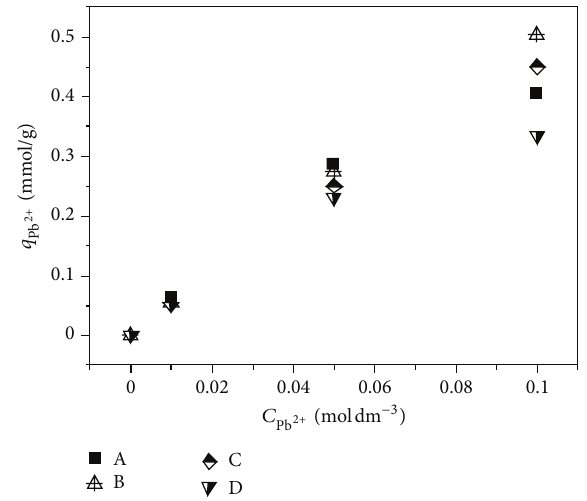
Figure 1: Lead(II) adsorption capacity versus initial concentration; the sample was immersed in different concentrations of aqueous Pb(NO 3 ) 2 solutions for 24 h, respectively.